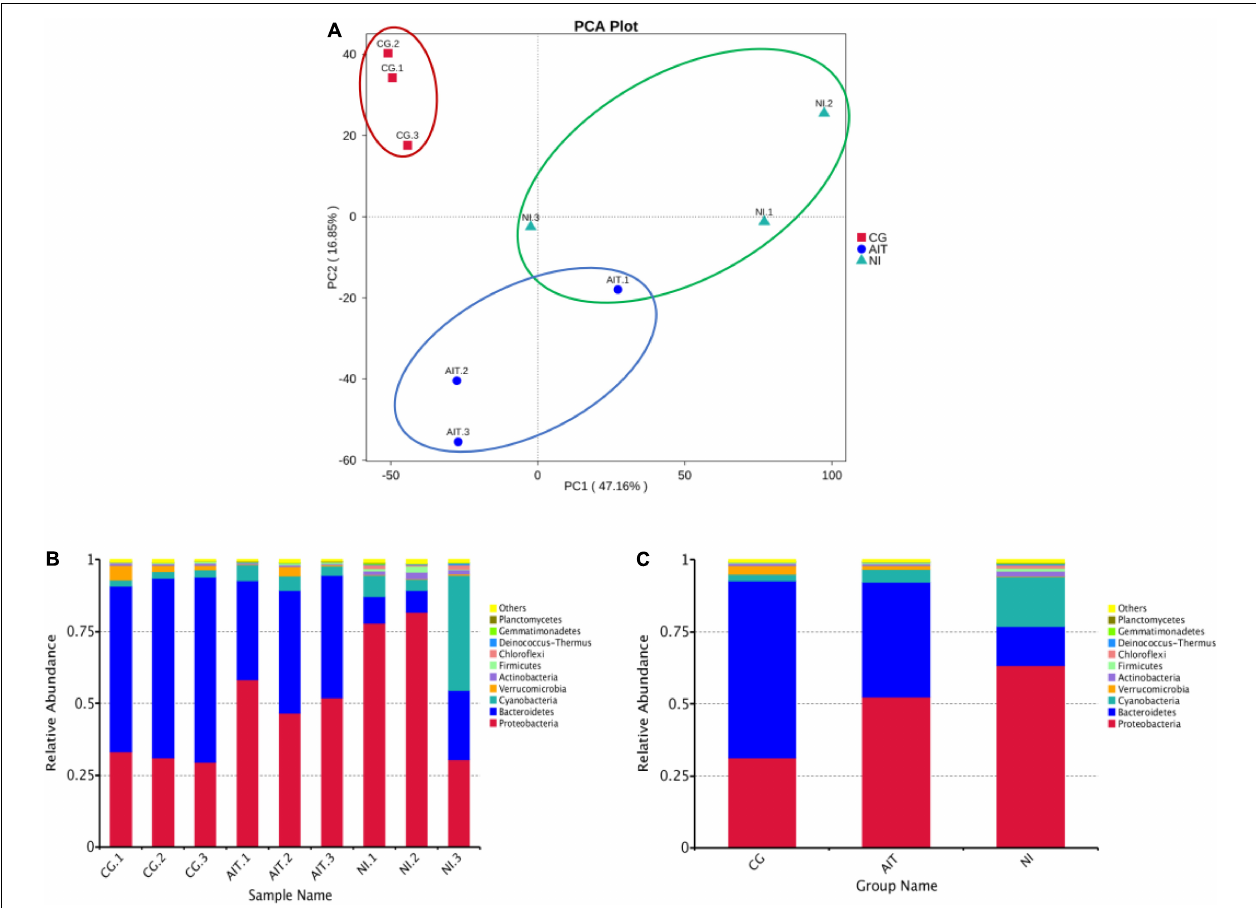
FIGURE 7 | PCA score plot of microbial populations in bio-eroded shells and changes in their relative abundances. (A) PCA score plot; (B) relative abundance of microbial populations on the shell of a single bio-eroded shells; (C) relative abundance of microbial populations on the shell under different treatment groups; (CG) control group. AIT, artificial infection group; NI, natural erosion